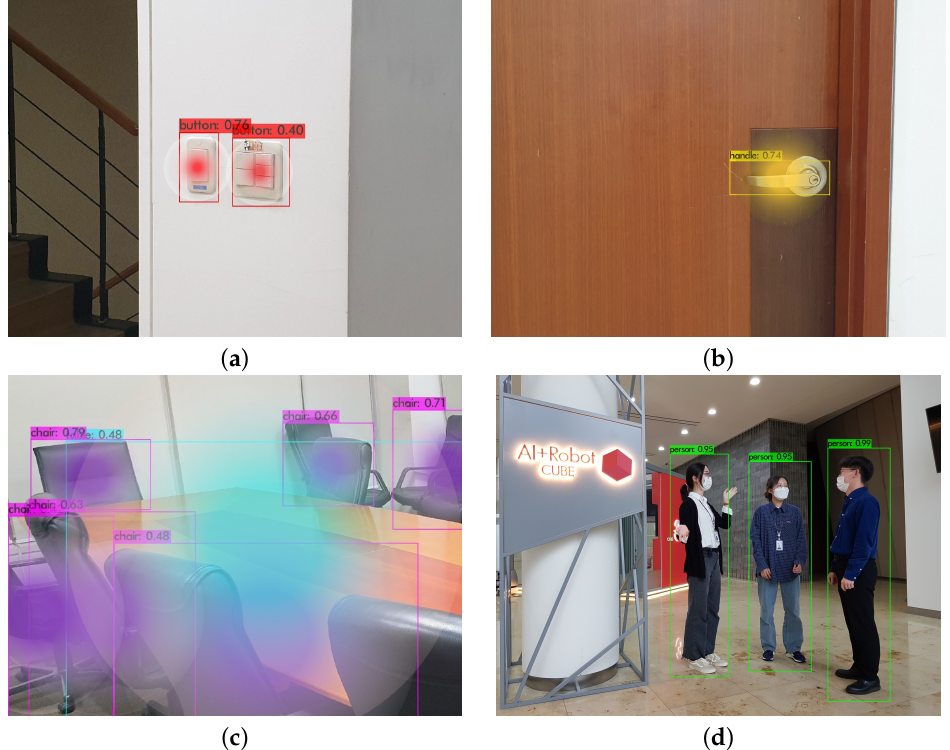
Figure 4. Target object detection results: ( a ) button, ( b ) handle, ( c ) chair and table, ( d ) person. The color space in the bounding box visualizes the bacterial distribution on the target object.